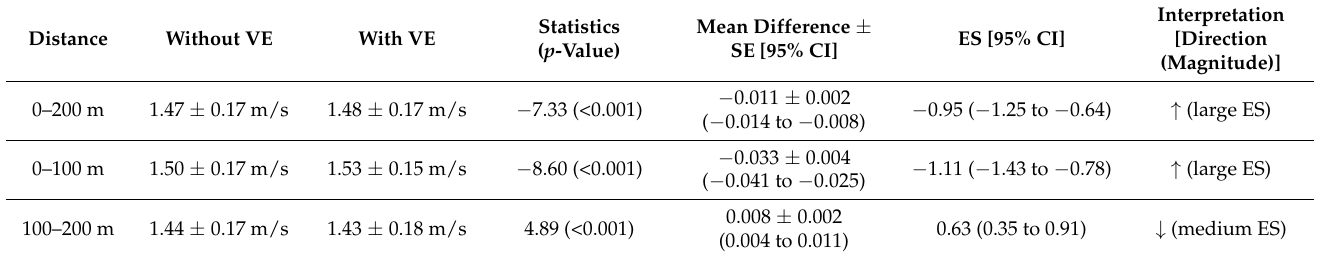
Table 2. Performance with and without verbal encouragement (VE), and changes in performance broken down according to the distance. Abbreviations: ↑ improved; ↓ , worsened; CI, confidence interval; SE, standard error; ES, effect size.